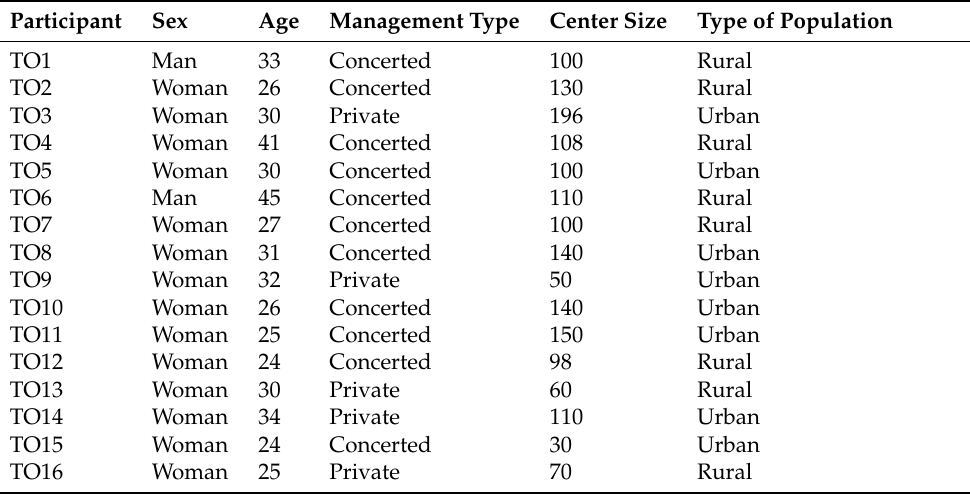
Table 1. Main Sociodemographic